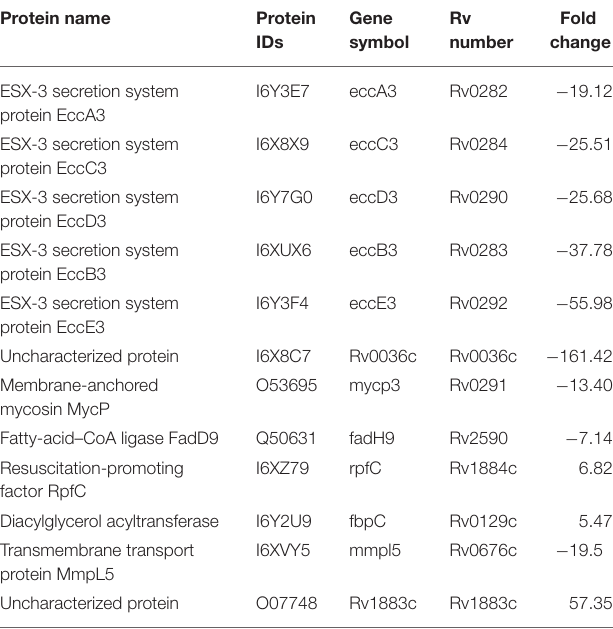
TABLE 3 | List of the M. tuberculosis differentially abundant proteins and corresponding fold changes involved in type 7 secretion